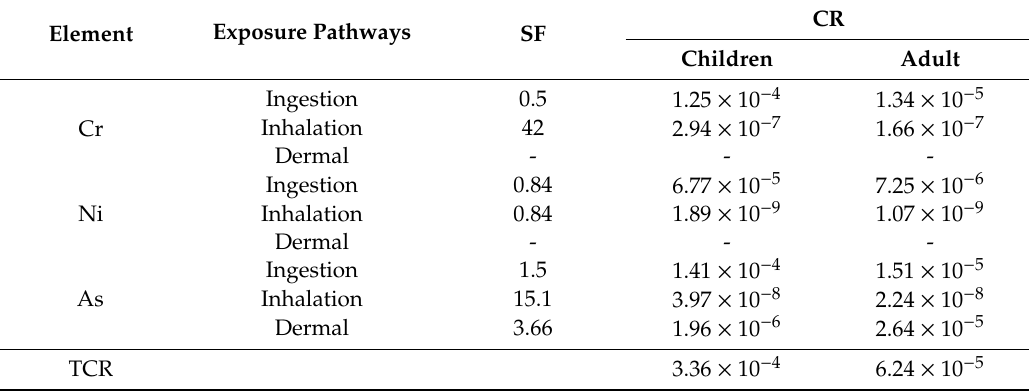
Table 4. Carcinogenic health risk from metals in the volcanic soil and volcanic ash.